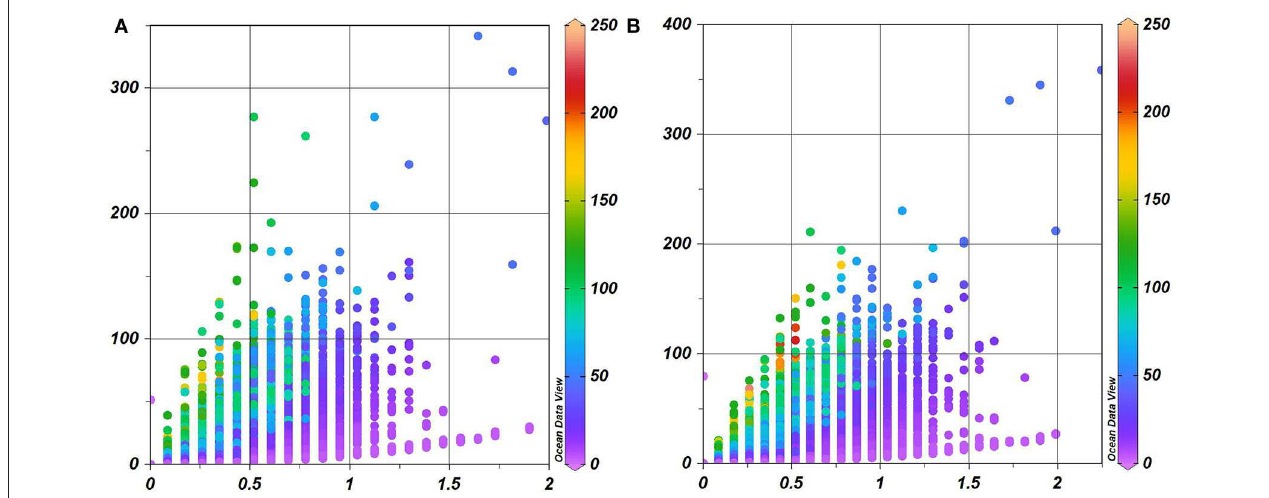
FIGURE 13 | Scatterplots of spectral amplitudes of kinetic energy (vertical axis) and nearbed velocities (horizontal axis) in 1961–1965 (A) and 2000–2005 (B) . Color scale indicates the water depth.